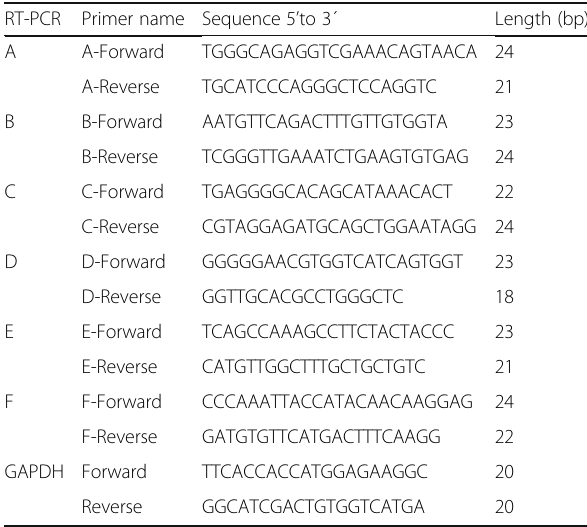
Table 1 Sequence of the primers used to perform the PCR for the different fragments of ataxin-2 and GAPDH as loading control RT-PCR Primer name Sequence 5 ’ to 3´ Length